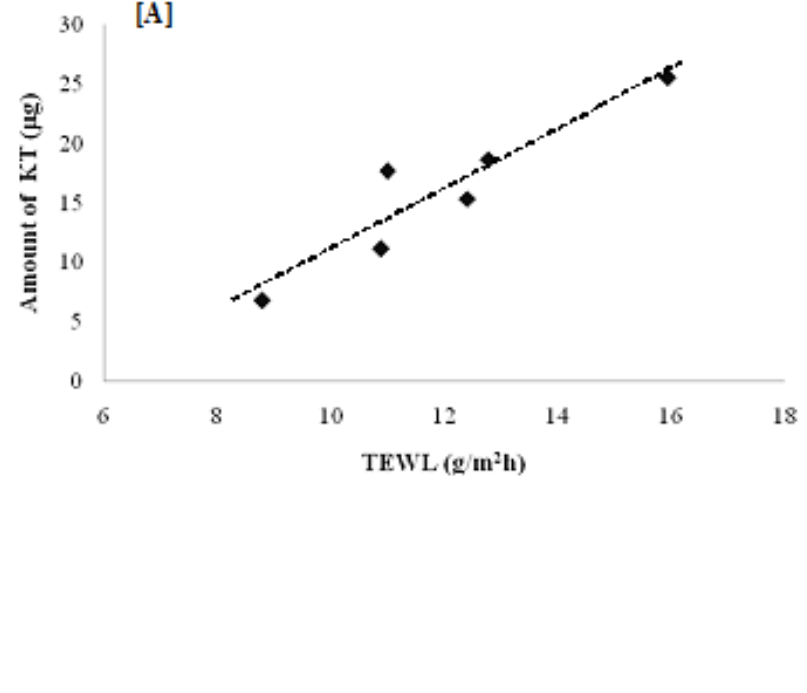
Figure 8. Correlation between volunteer transepidermal water loss (TEWL) value and ( A ) total amount of KT permeated; ( B ) penetration distance. The lines are from simple linear regression. In ( B ), the point marked in red was not taken into account for r 2